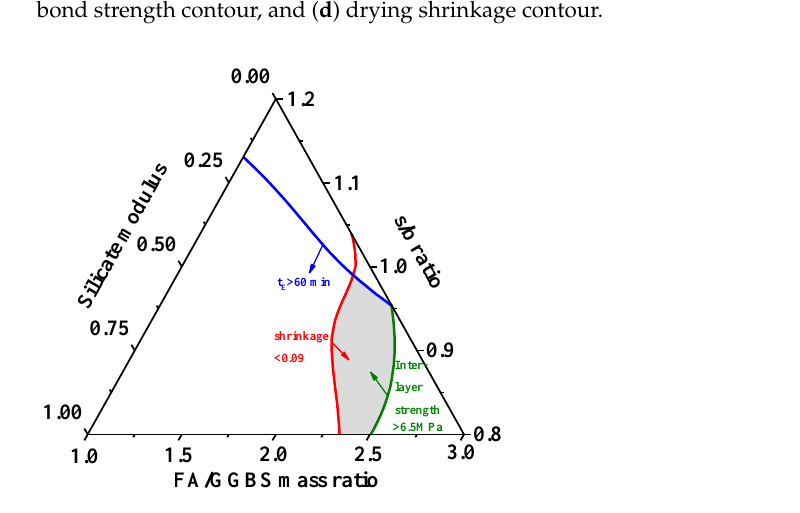
Figure 13. Optimization of the mix proportion of AAFS mortar for 3D printing manufacture.